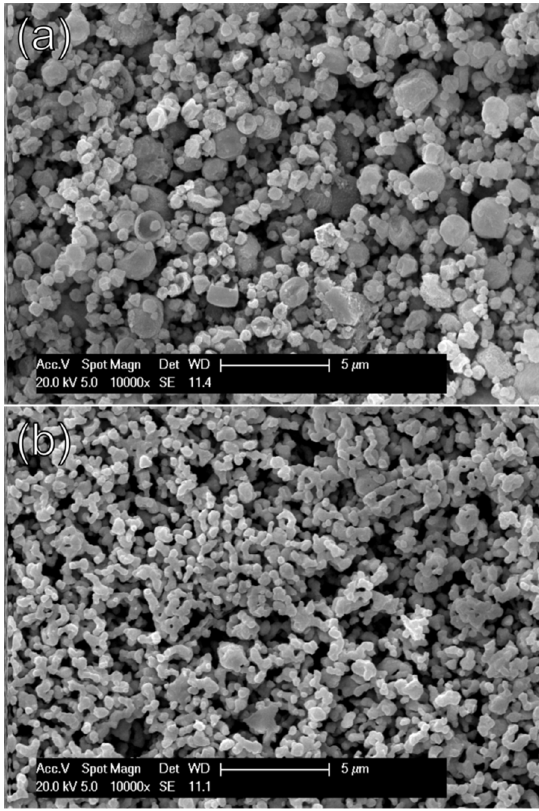
Figure 5. SEM micrographs of ( a ) as-prepared NSP powder at 750 °C and ( b ) after calcination at 900 °C.